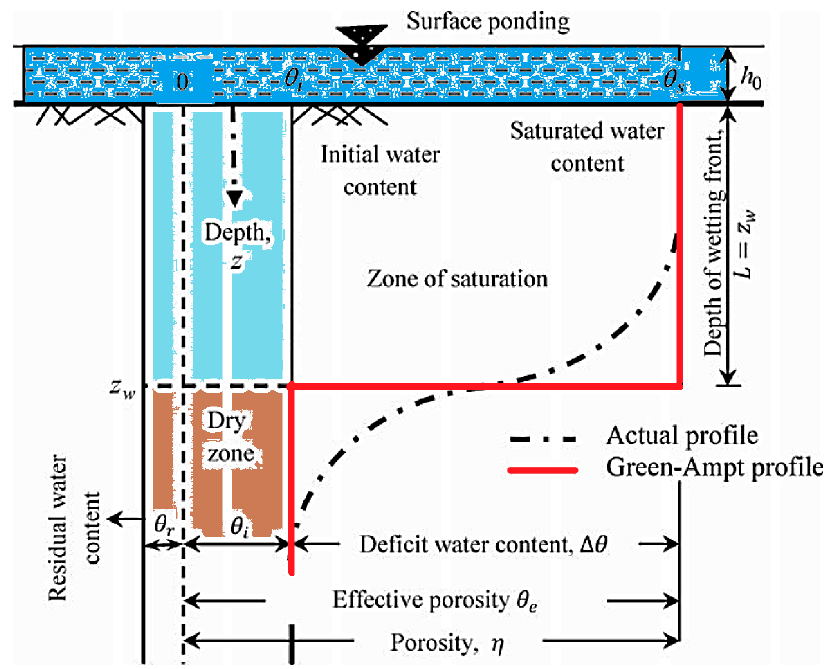
Figure 3. The illustration of 1D vertical Green-Ampt infiltration model, reprinted from Ref. [101]. Philip [102] stated that the Green-Ampt model is an exact solution of the Richards model if the diffusivity D ( θ ) is a Dirac-Delta function with non-zero water content in the saturated zone. Hence, the Green-Ampt model is just a simplified tool for approximating wetting front advancing depth. Kale and Sahoo [101] reviewed the Green-Ampt model with modified versions and concluded that the prediction of this model is sensitive to the effective hydraulic conductivity. The main advantage of this model is less demand of input parameters, compared to the Richards model in need of SWRF and HCF. For the Richards model, SWRF and HCF have to be experimentally measured in the laboratory for a long time due to equilibrium condition achievement. In contrast, the Green-Ampt model only needs effective hydraulic conductivity, ponding head, porosity, and dry zone initial water content. Each of these can be easily determined using standard soil mechanic tests in a shorter period. However, ignoring water content distribution in unsaturated soil constrains the accuracy of this model. Furthermore, due to the inhomogeneous nature of the ground, this averaged effective hydraulic conductivity can hardly be determined [101].